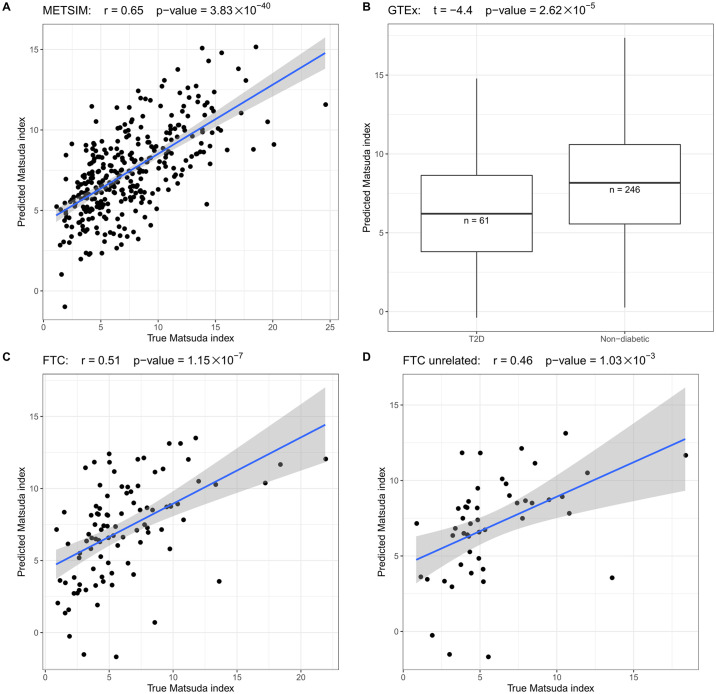
The predicted Matsuda index is well concordant with the true Matsuda index values in 3 different cohorts: METSIM, GTEx, and FTC.(A) In METSIM, the estimated and true Matsuda index are significantly associated. (B) In GTEx, the predicted Matsuda index is significantly higher in non-diabetic individuals when compared to the T2D patients. (C) In FTC, the estimated and true Matsuda index are significantly associated. (D) We randomly choose one individual from each twin pair to select the unrelated individuals from FTC. Among the unrelated individuals, the estimated and true Matsuda index are also significantly associated, indicating that the twin status did not bias the prediction of the Matsuda index.